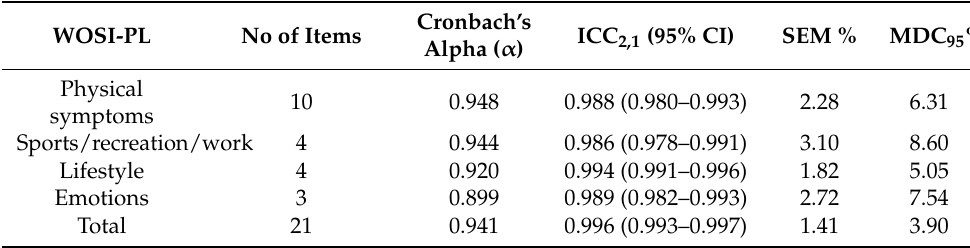
Table 4. Results of the reliability analysis: internal consistency ( n = 74), test–retest reliability and measurement error ( n = 71).